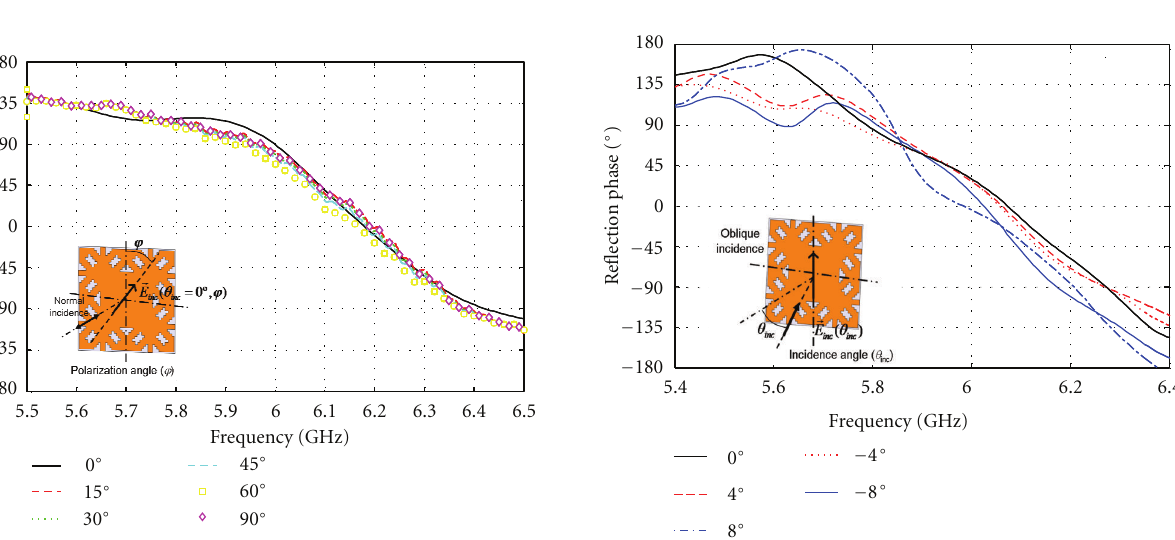
Figure 9: Reflection phase of the manufactured smooth prototype for di ff erent incident angles ( θ inc